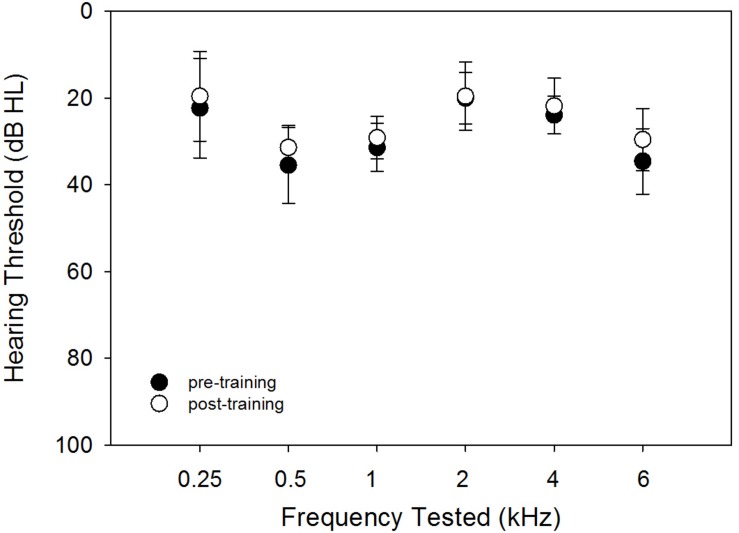
The pre- (solid circles) and post-training (open circles) hearing thresholds using pulsed tones at different frequencies. The means (circles) and the standard deviations (error bars) are plotted.